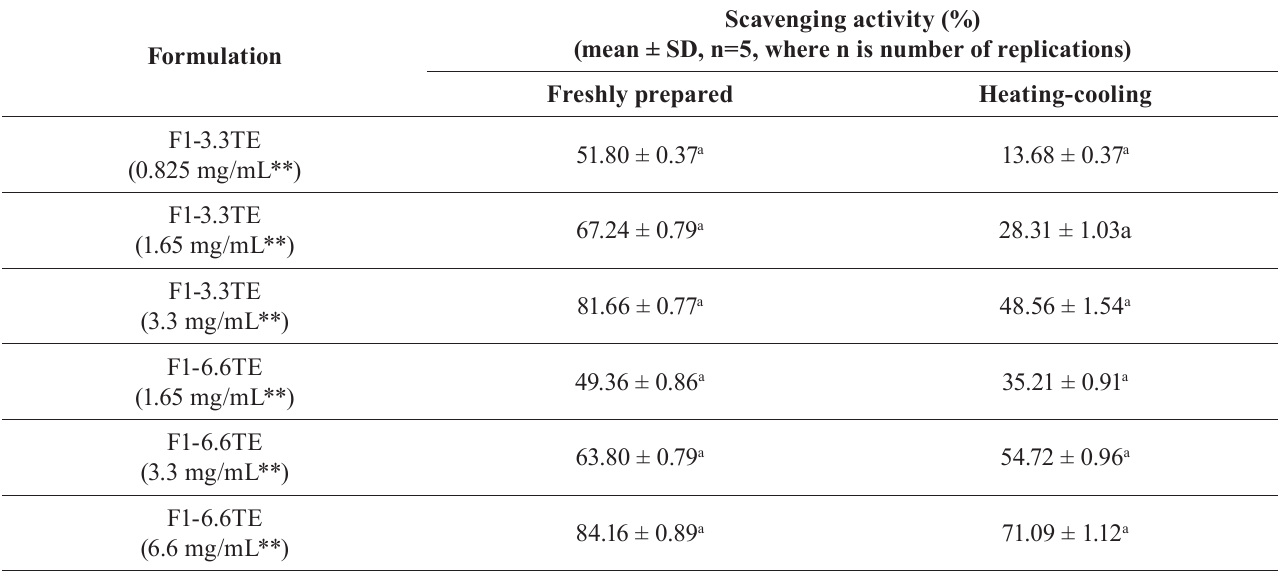
TABLE VII - Percent scavenging activity of tamarind extract loaded nanoemulsions determined by DPPH assay. Scavenging activity (%) (mean ± SD, n=5, where n is number of Formulation